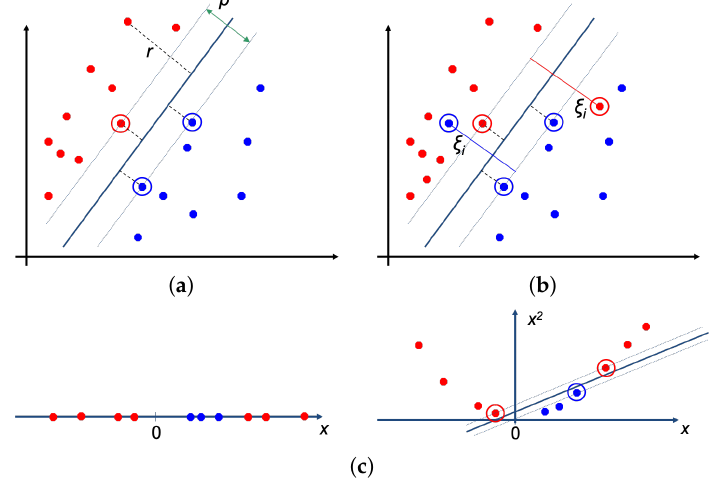
Figure 2. Examples of different support vector machine (SVM) problems. Highlighted observations are the support vector, solid line is the separator hyperplane and dashed lines represent the optimized margin. ( a ) Linear SVM applied over a linear separable problem. ( b ) Linear SVM applied over a linear non-separable problem. ( c ) Non-linear separable problem solved by using a kernelized